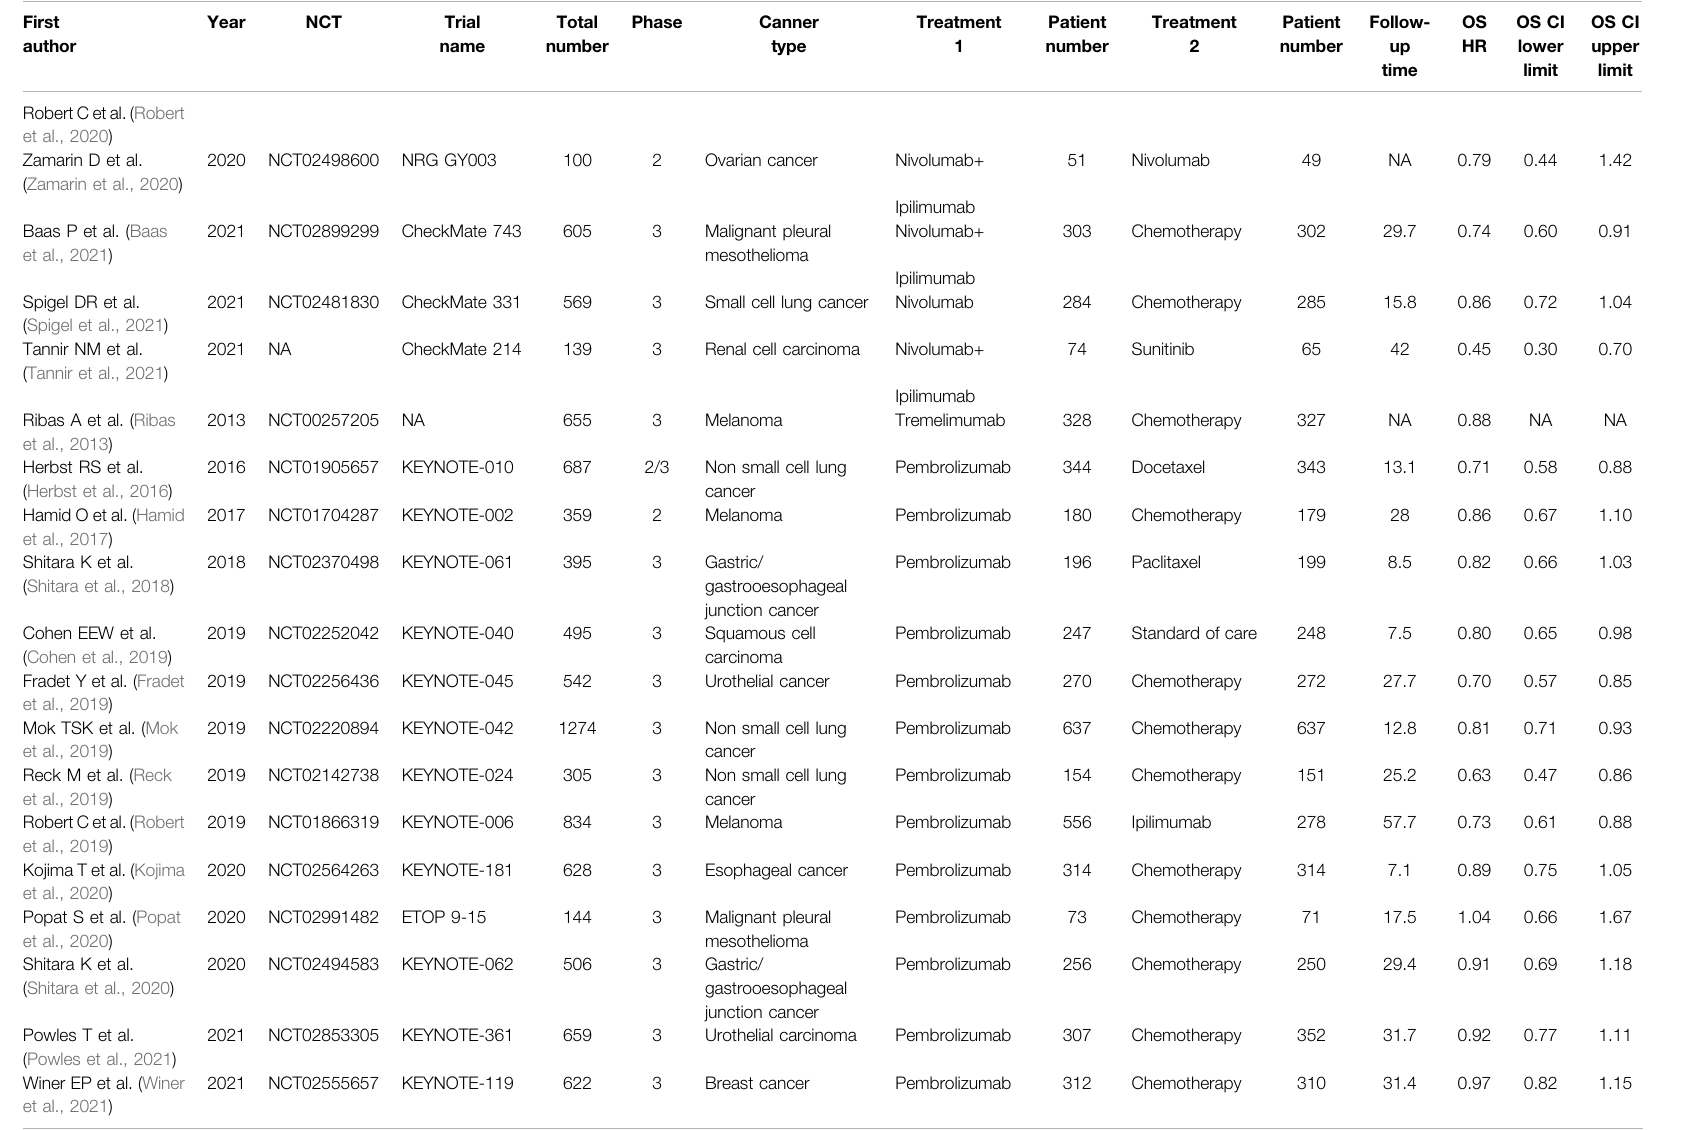
OS = Overall survival. HR = Hazard ratio. CI = Con fi dence